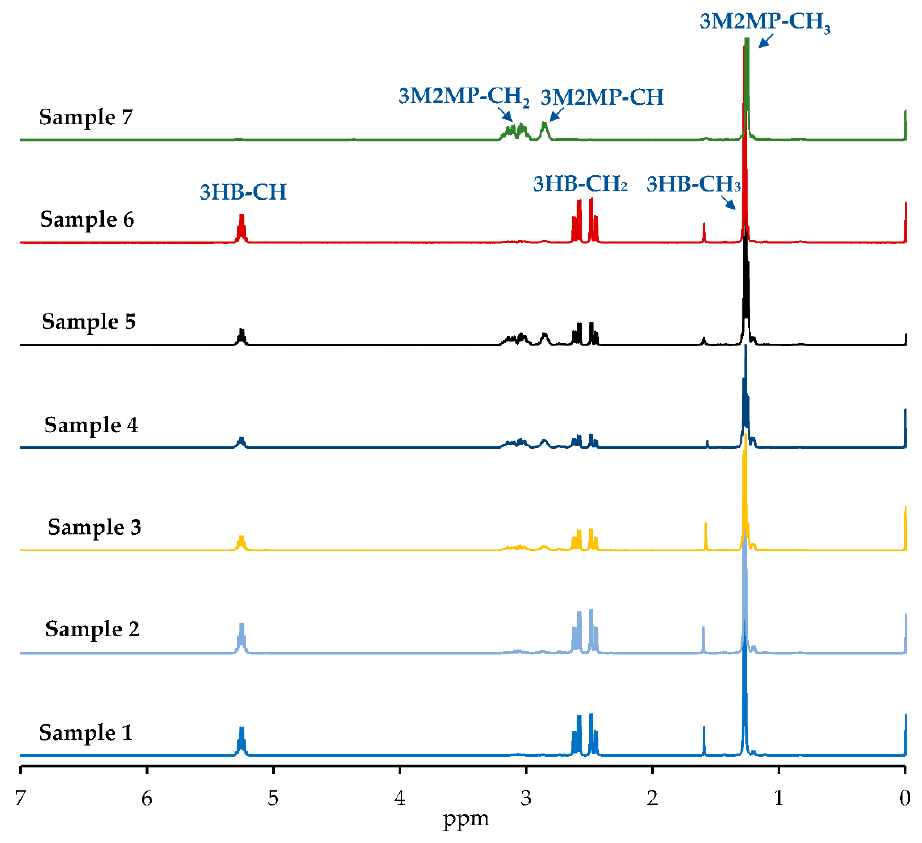
Figure 4. 1 H NMR spectra of Sample 1 (3M2MP 5.5 mol%), Sample 2 (10.1 mol%), Sample 3 (34.2 mol%), Sample 4 (53.9 mol%), Sample 5 (54.8 mol%), Sample 6 (10.7 mol%), and Sample 7 (100 mol%). Table 2. D value and sequence distribution of P(3HB- co -3M2MP) samples.